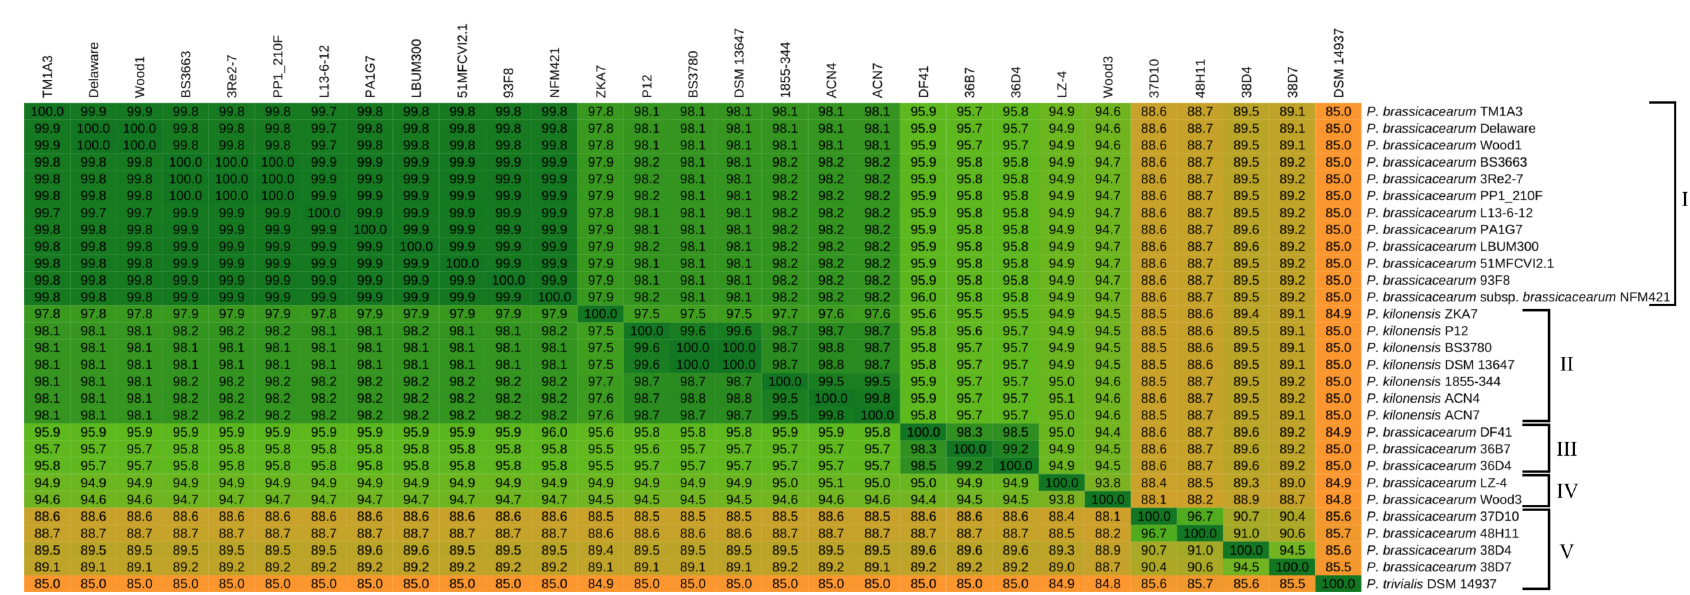
Figure 3. Average Amino-acid Identity (AAI) matrix of genome sequenced P. brassicacearum and P. kilonensis strains. Emerging clusters/groups are indicated with brackets and numbered I-V. The protein sequences of orthologous core genes of the genomes were analyzed for their mean percent identity values. The values were calculated within the EDGAR2.0 platform